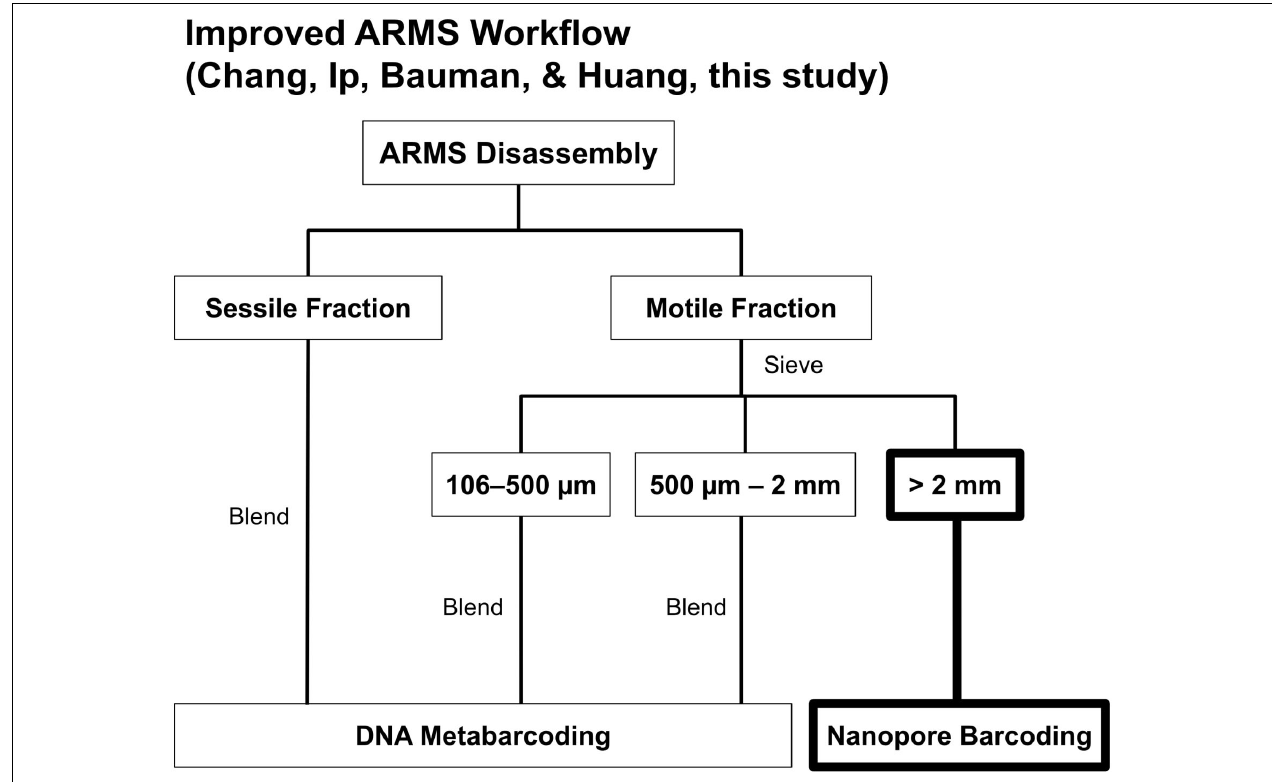
FIGURE 1 | The ARMS processing workflow by Leray and Knowlton (2015). We replaced Sanger sequencing of > 2-mm specimens with nanopore barcoding highlighted in bold.